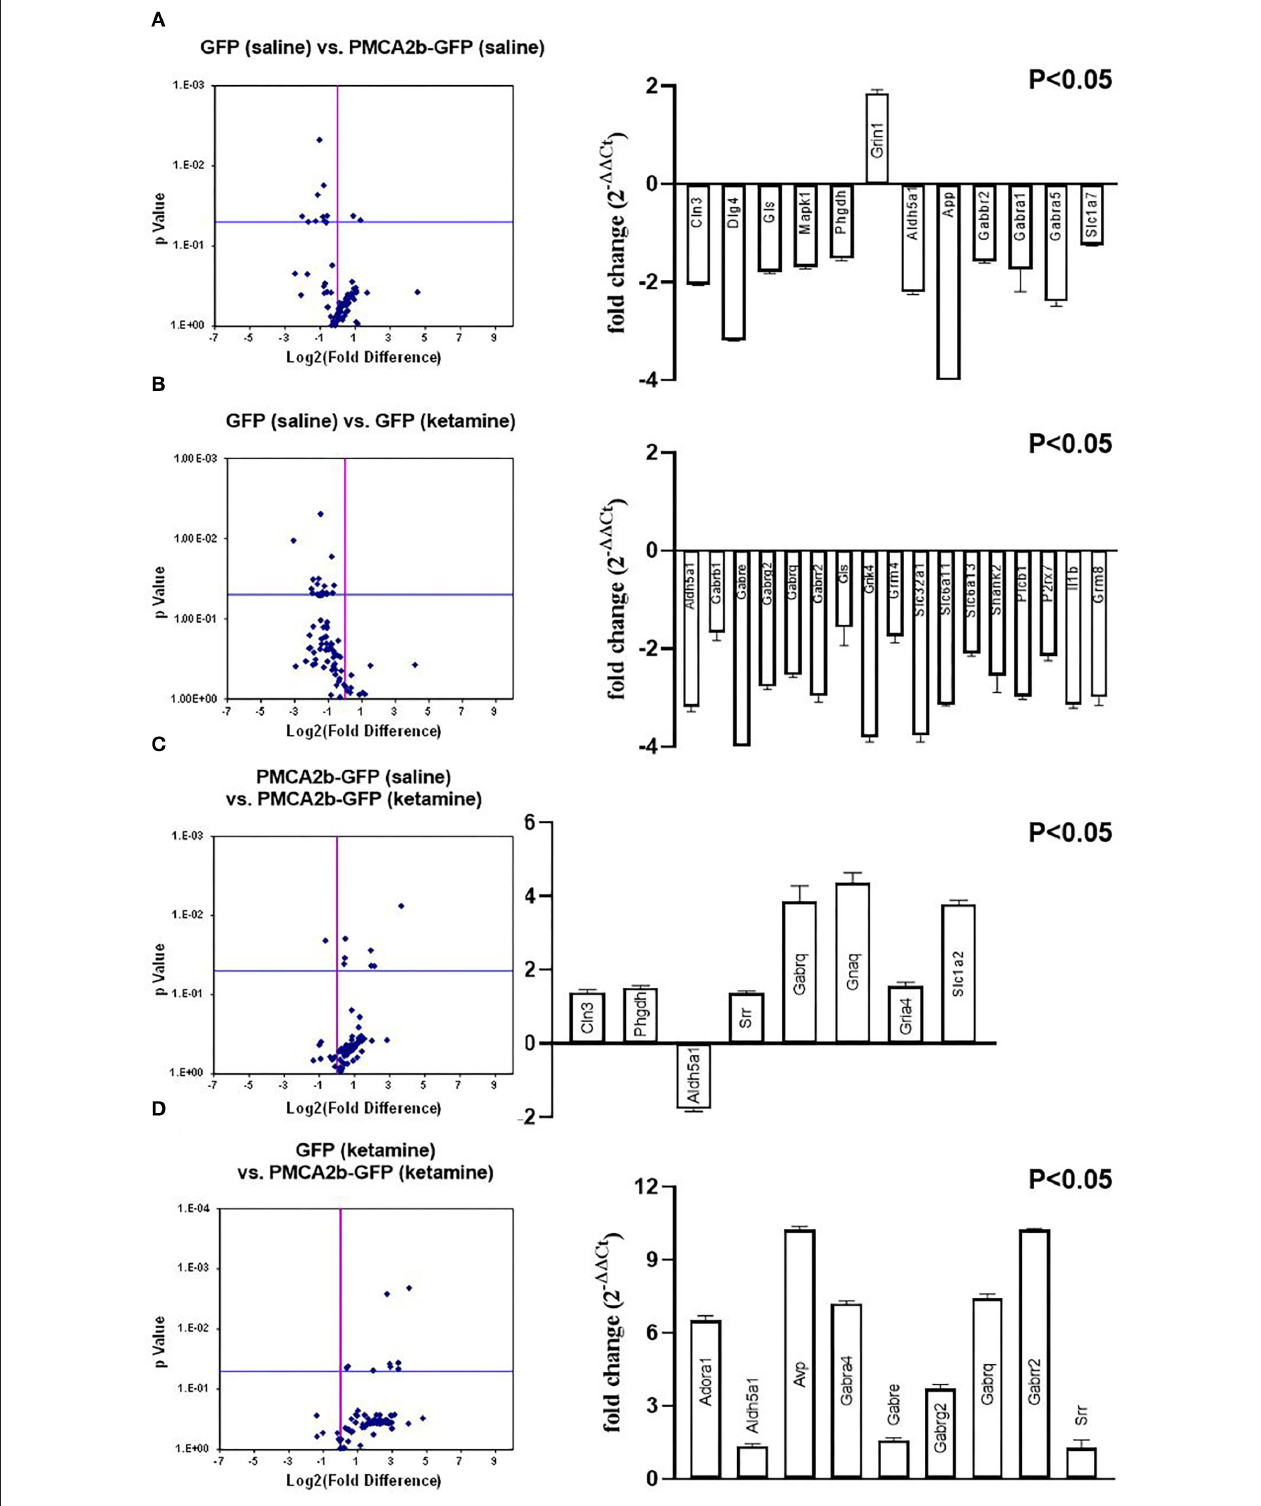
FIGURE 5 | Microarray screening of fundamental genes involved in glutamate and GABA signaling. The SABiosciences rat microarray (PARN-152Z) was used to evaluate changes in the expression of genes involved in GABA and glutamate signaling. [ (A–D) , left panel] Volcano plot analysis of expression changes calculated using company-provided software. [ (A–D) , right panel] Genes whose expression was statistically significant ( P < 0.05).